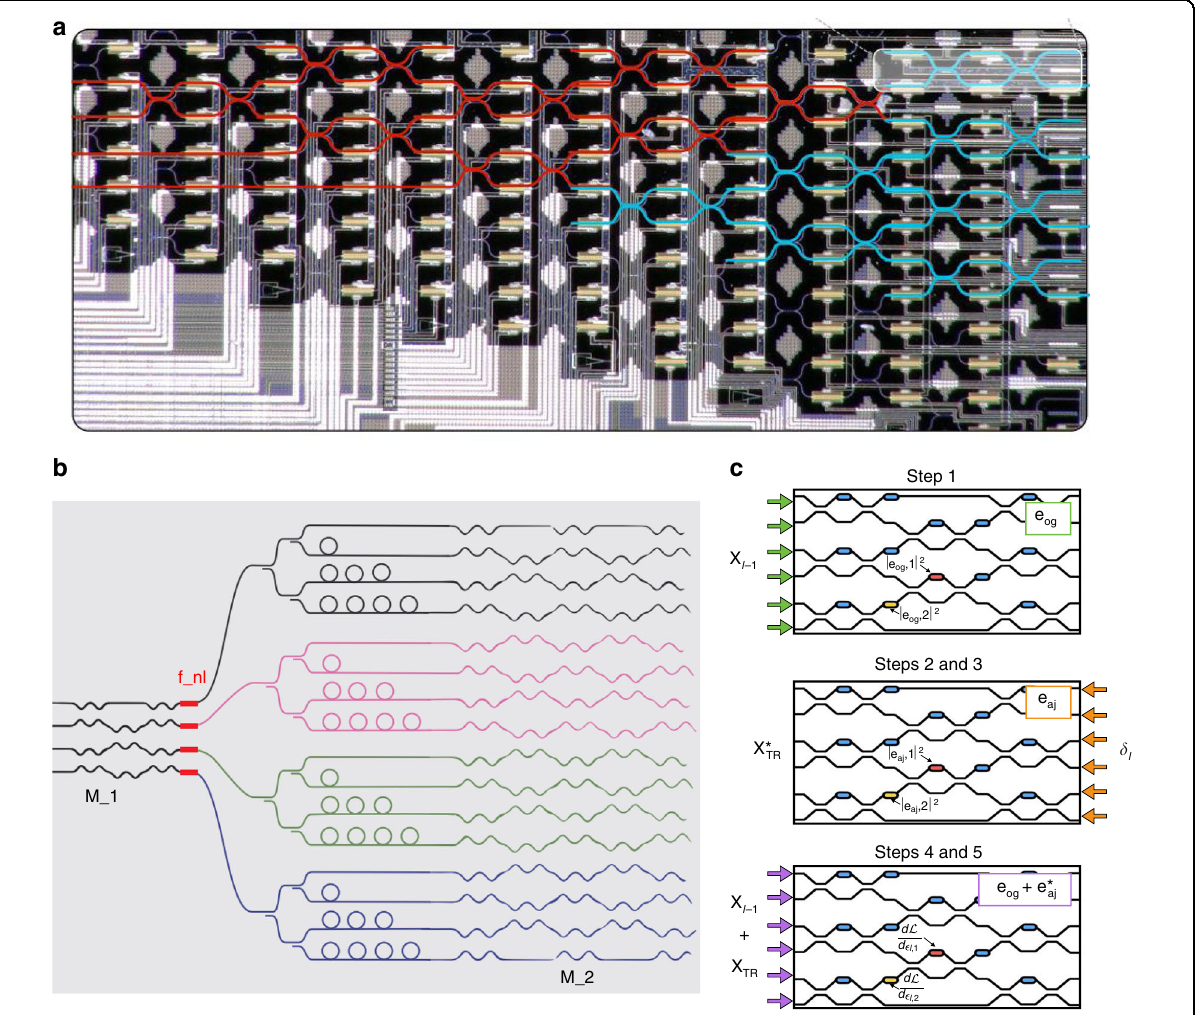
Fig. 10 MZI-MVMs for ONNs. a Optical feedforward neural network 3 . b Optical convolutional neural network 71 . c In situ training of an ONN 127 . a Reproduced from ref. 3 with permission of Springer Nature: Nature Photonics. b Reproduced from ref. 71 with the permission of the authors. c Reprinted with permission from ref. 127 © The Optical